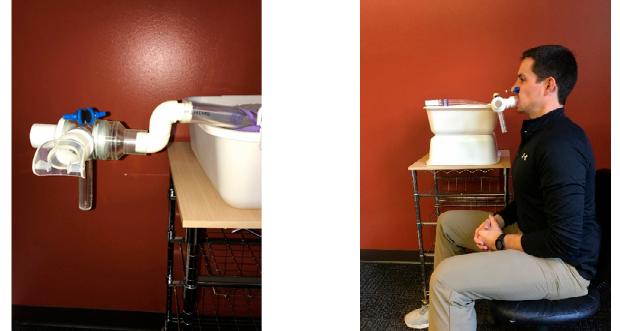
Figure 2. Device photos (front and side view). A Hans Rudolph mouthpiece equipped with a two ‐ way nonrebreathing T ‐ valve. The mouthpiece is connected to the 3/4 ʺ Tygon Tubing via two 3/4” PVC 90° Street Elbows, and a one ‐ way valve is placed on the distal end of the